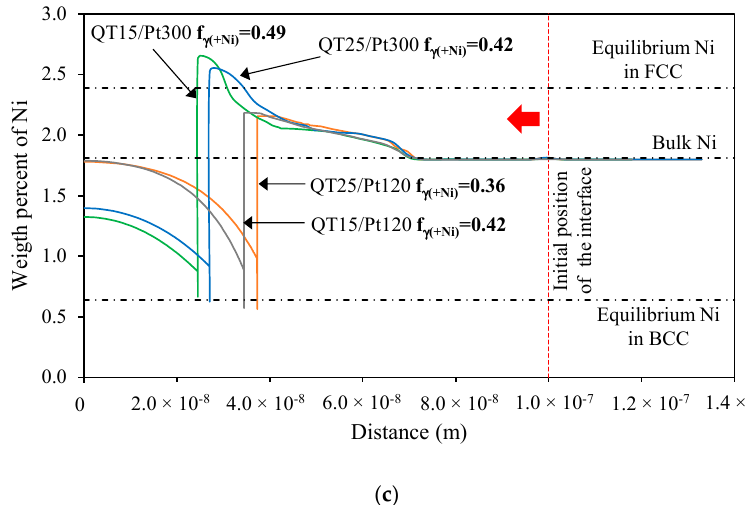
Figure 12. ( a ) Schematic of the system considered in DICTRA simulations; ( b , c ) DICTRA calculations of the Mn and Ni composition profiles, respectively, at the martensite (left)/austenite (right) system. The calculation was done considering the chemical composition of M-MnNi steel, 650 °C (PT), 120 s and 300 s (Pt) and 0.15 and 0.25 austenite volume fractions as initial conditions (QT15 and QT25, respectively).